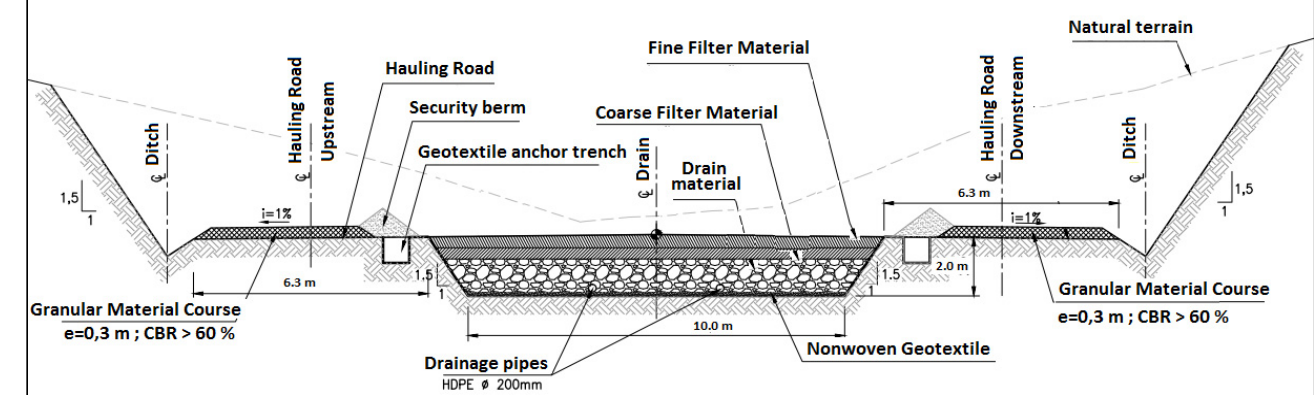
Figure 17. Filtered TSF Seepage Underdrainage System—Typical Cross Section [18].